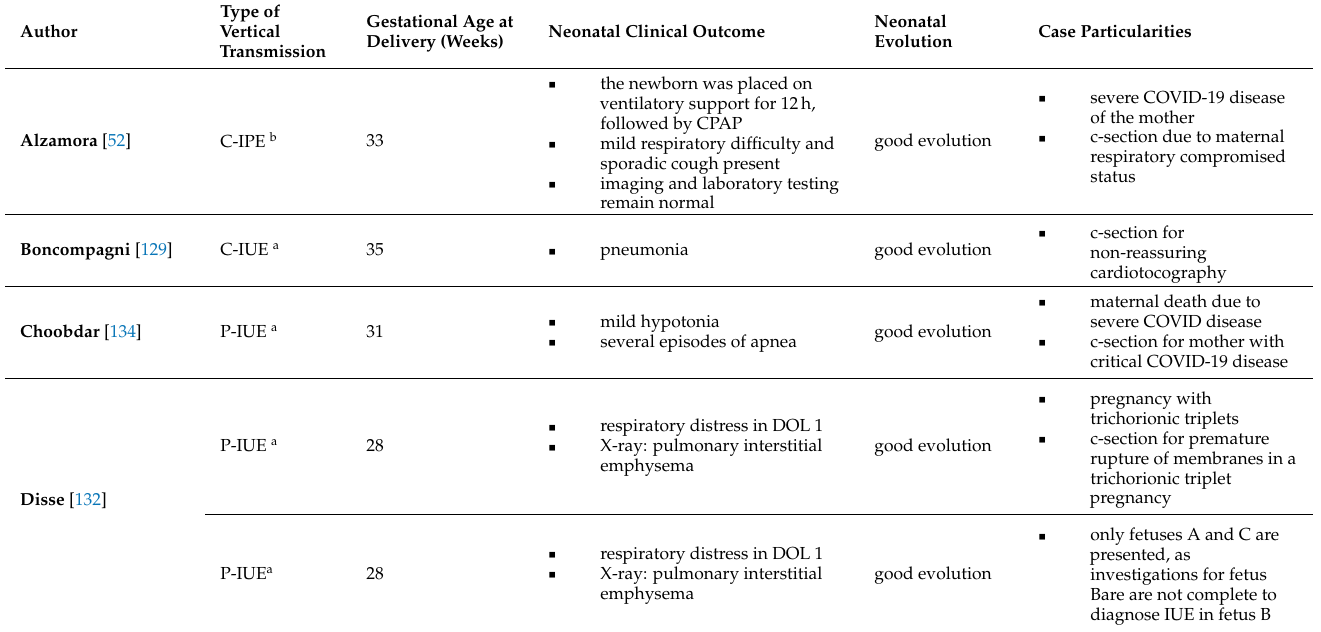
Table 3. Essential characteristics of each symptomatic newborn included in the review. The studies are specified in the alphabetical order of the first author’s